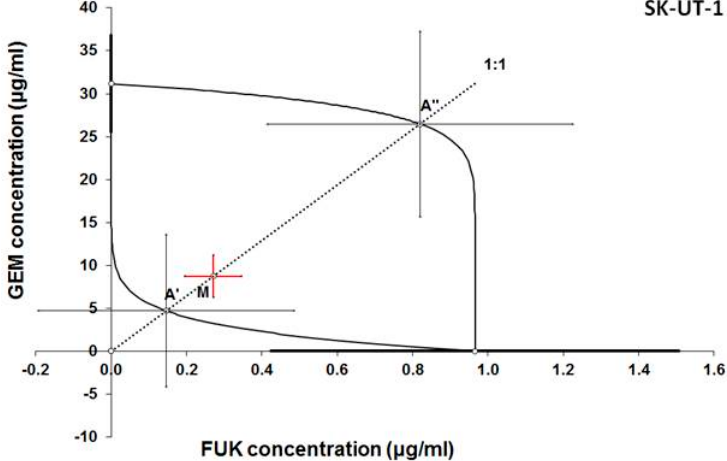
Figure 2. Isobologram showing interaction between gemcitabine (GEM) and fucoidan (FUK) with respect to their anti-proliferative effects in the cancer cell line (SK-UT-1) measured in vitro by the MTT assay. The experimentally-derived IC 50 mix value is placed within the area of additivity and indicates additive interaction between GEM and FUK in this cancer cell line.